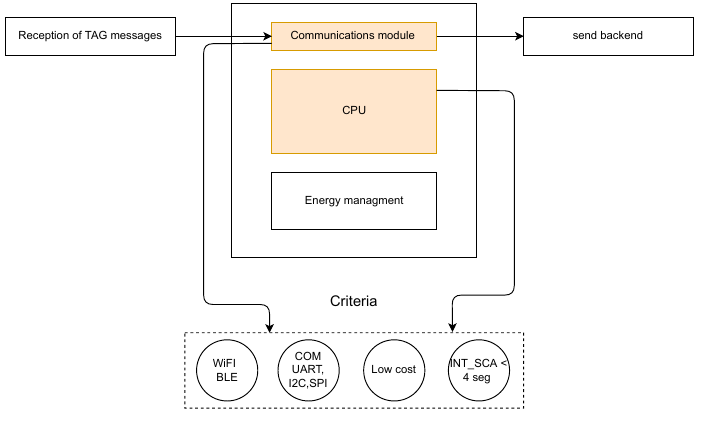
Figure 4. General concept of the scanning